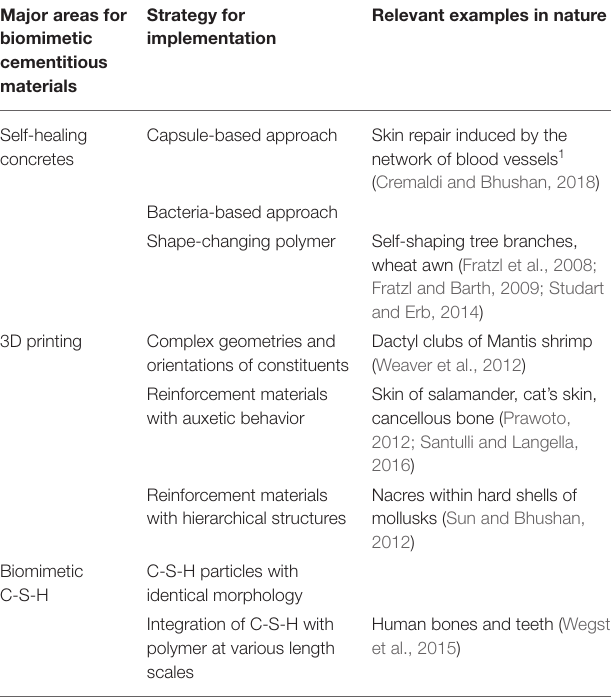
TABLE 1 | Summary of three major implementation routes for biomimetic, cementitious